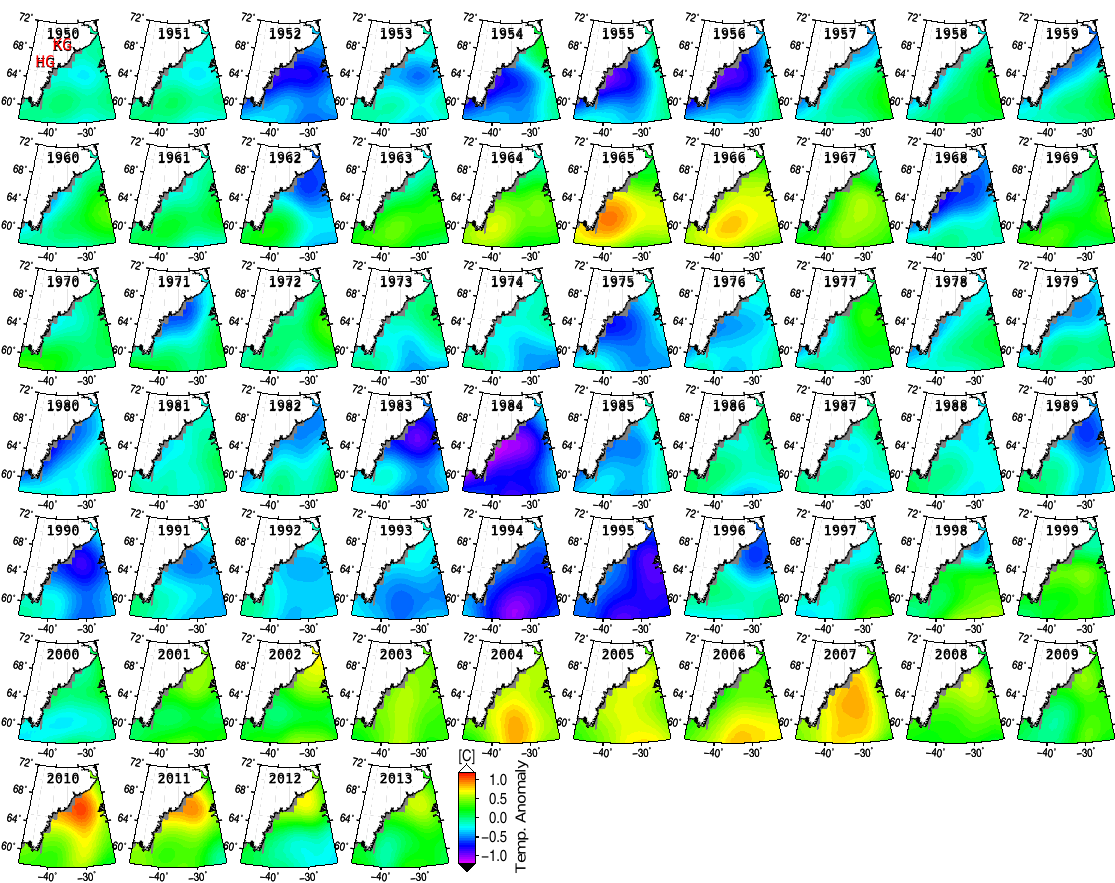
Figure 2. Mean annual sub-surface water temperature anomalies at a depth of